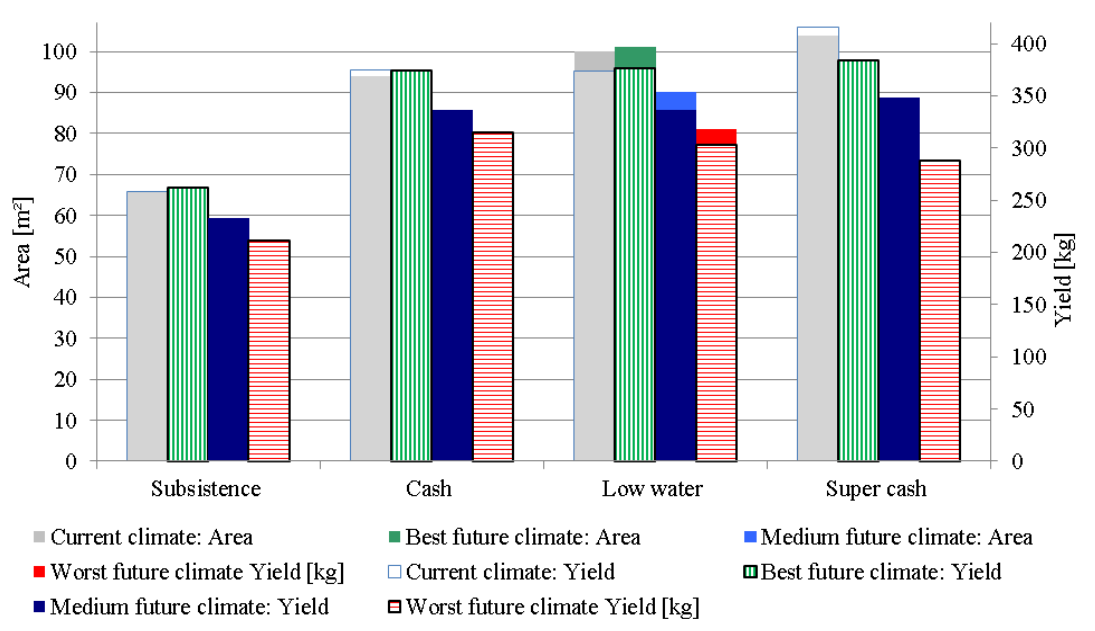
Figure 9. Area (m 2 ) and yield (kg) of gardens with adapted area that can be fully irrigated depending on climate scenario (full irrigation in three out of four